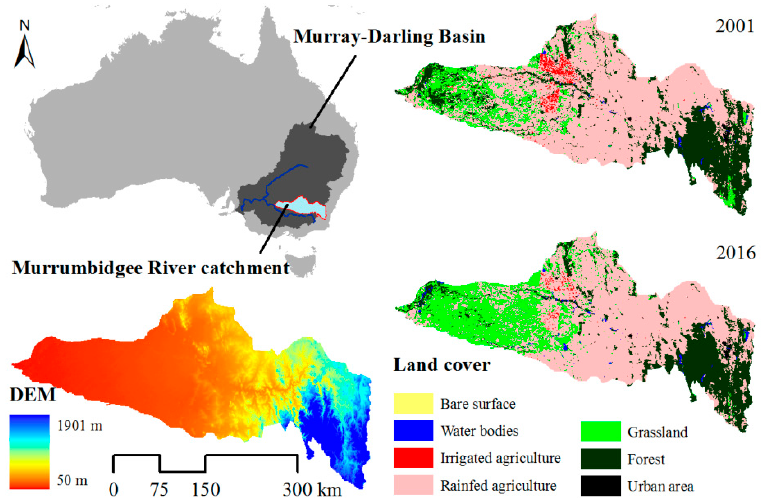
Figure 2. The location of the Murrumbidgee River catchment (MRC) and its topography and land cover.